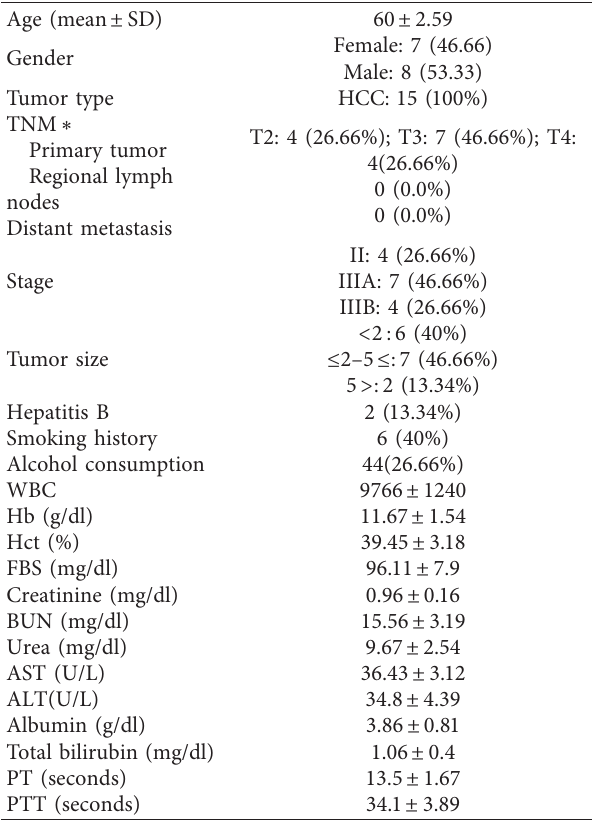
Table 2: The clinicopathological characteristics of